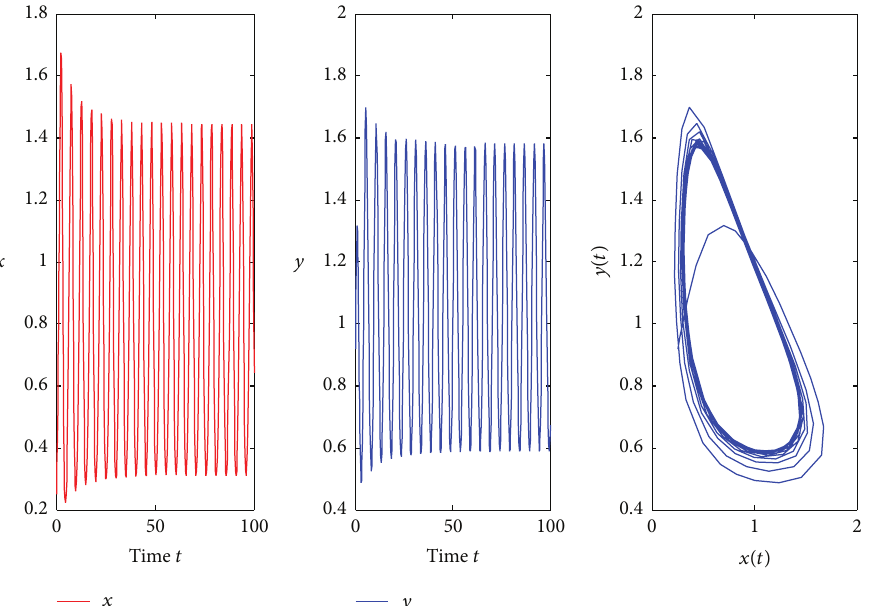
Figure 6: 𝐸 ∗ is unstable for 𝜏 2 = 0.5, 𝜏 1 = 1.15 > 𝜏 ∗ 10 = 1.0931 with initial values